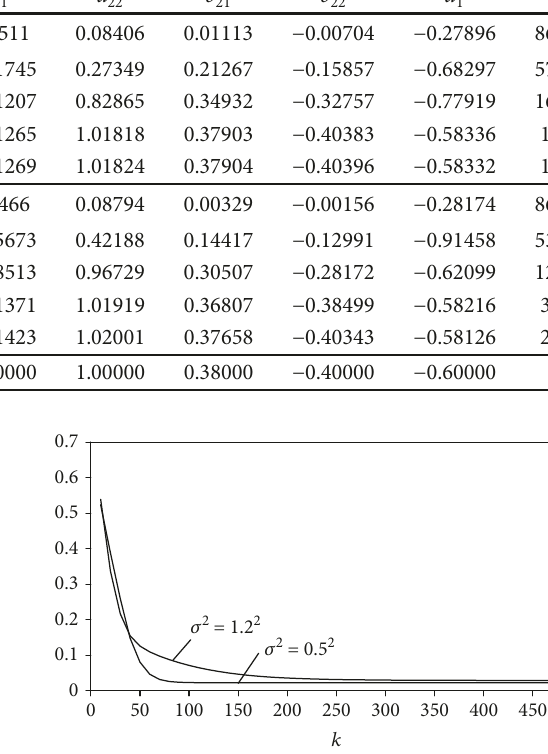
Figure 5: The CARMA-FGI estimation errors δ with di ff erent noise variances L = 2000